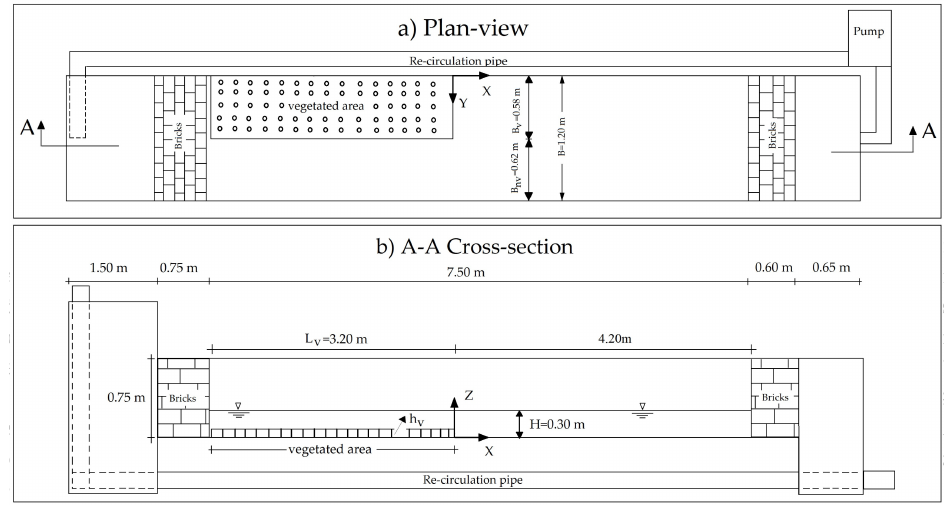
Figure 2. Schematic views of the channel: ( a ) Plan view of the flume; ( b ) A-A cross-section of the flume.